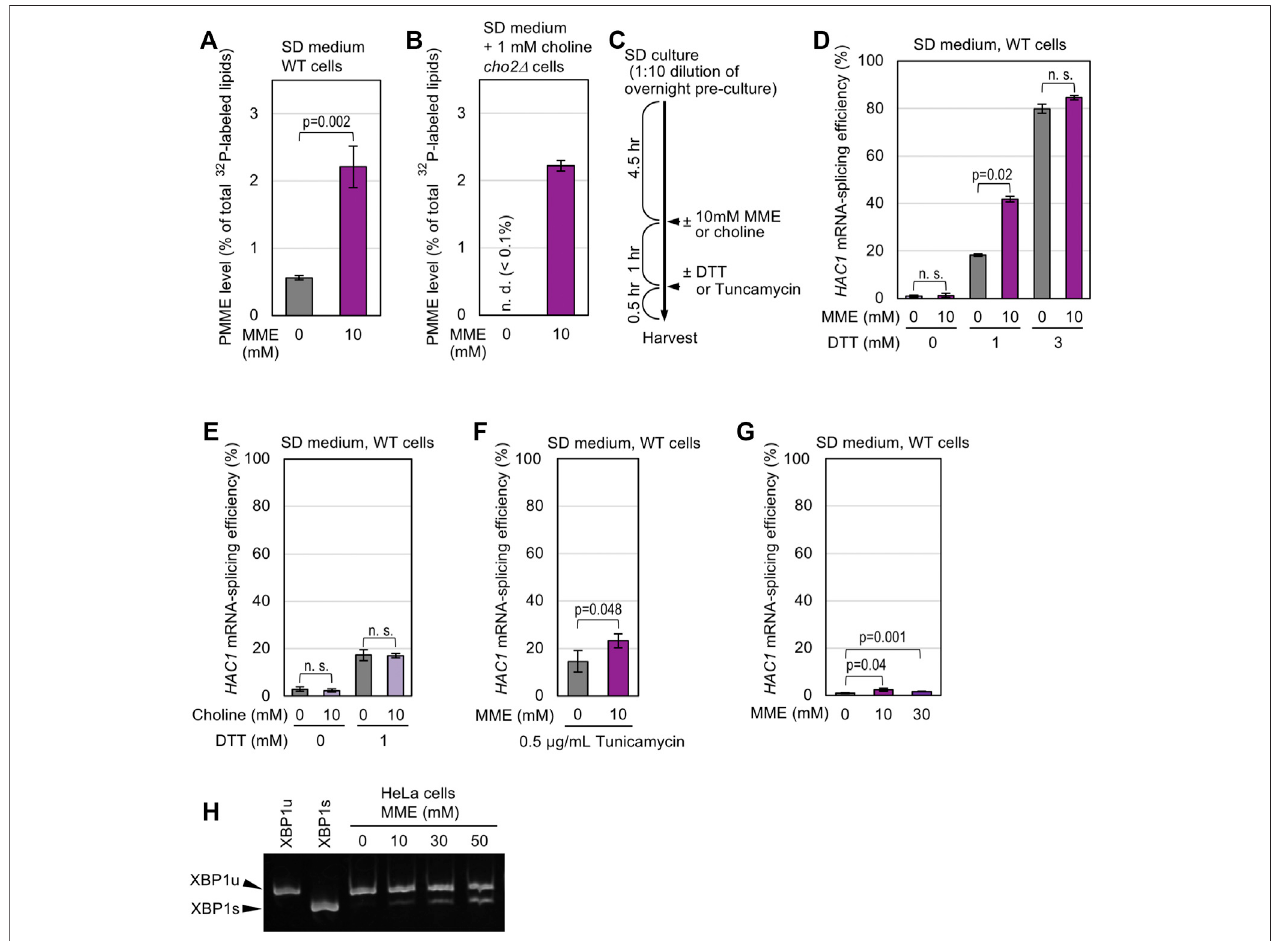
FIGURE2| InductionorenhancementoftheIre1-mediatedmRNAsplicingbyextracellularlysupplementedMMEinyeastandmammalian cells. (A) Wild-type(WT) yeast cells (BY4741) were grown in SD medium containing 32 P-orthophosphate, which was supplemented with or without 10 mM MME before further culturing for 1 h. Afterharvesting, theirlipidicextractswereassayedforPMMElevelsasshown in SupplementaryFigureS1 . (B) Exceptforthesupplementation ofculturemedium with choline, thesameanalysis was performed as in (A) using the cho2 Δ mutantversion ofBY4741. (C) Asillustrated, cells were grown in SD medium,into which MME (or choline) and/or DTT (or tunicamycin) were added. (D – F) After the chemical treatment shown in (C) , BY4741 cells (WT cells) were checked for HAC1 -mRNA splicing. (G) BY4741 cells (WT cells) were cultured in SD medium containing the indicated concentrations of MME for 1 h and were checked for HAC1 -mRNA splicing. (H) After addition of PMME into the medium and further culture for 1 h, HeLa cells were examined for XBP1-mRNA splicing using RT-PCR. On the “ XBP1u ” and “ XBP1s ” lanes, the PCR products from cDNAs of unspliced (XBP1u) and spliced (XBP1s) mRNAs were loaded as band-position markers. ns, not signi fi cant ( p > 0.05).